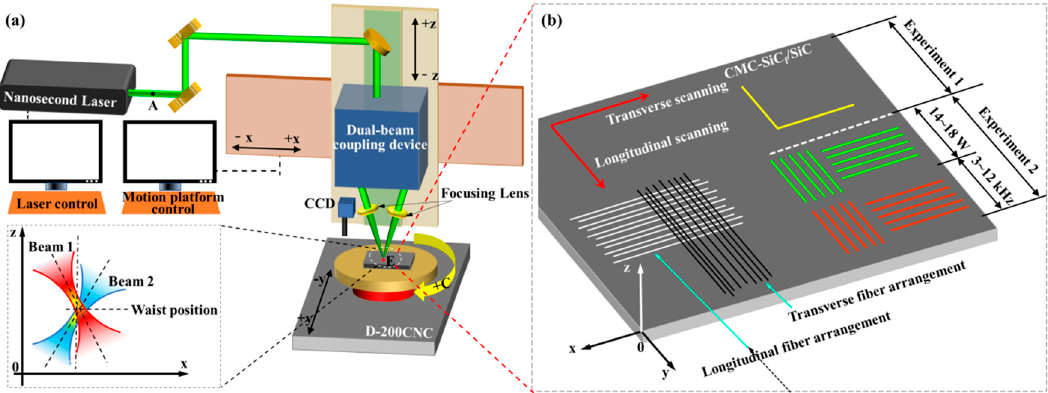
Figure 2. Grooving experimental platform and grooving experimental parameters. ( a ) Laser processing platform; ( b ) grooving experimental parameters.